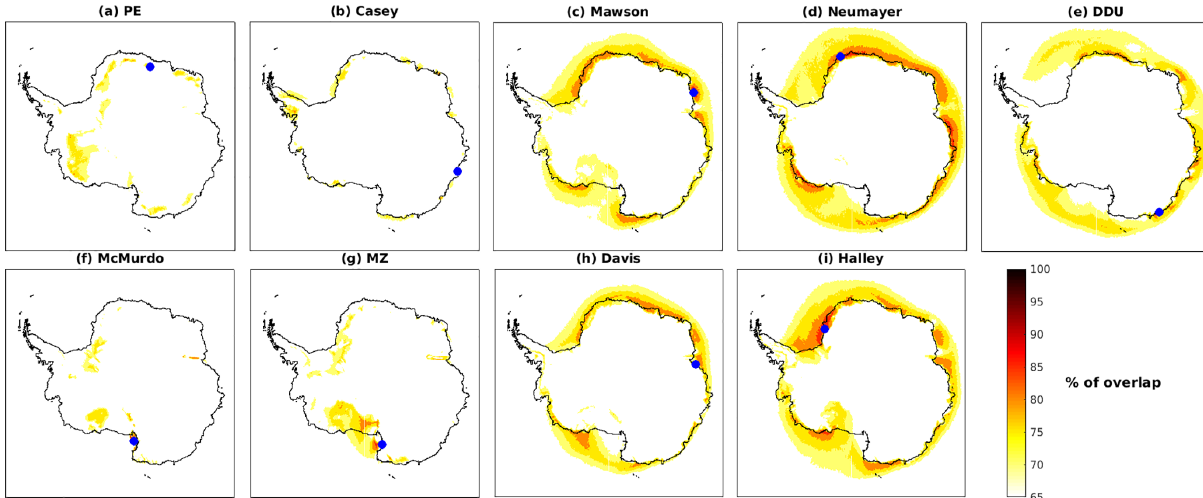
Figure 11. Spatial representativity of the low troposphere at the nine Antarctic stations. For each station (panel), colors indicate the minimum value reached by all the four overlaps between the independent distributions of the 500m temperature, 2000m temperature, 500m wind speed and 2000m wind speed at the ERA5 grid point with those at the station. In each panel, the location of the corresponding station is indicated with a blue